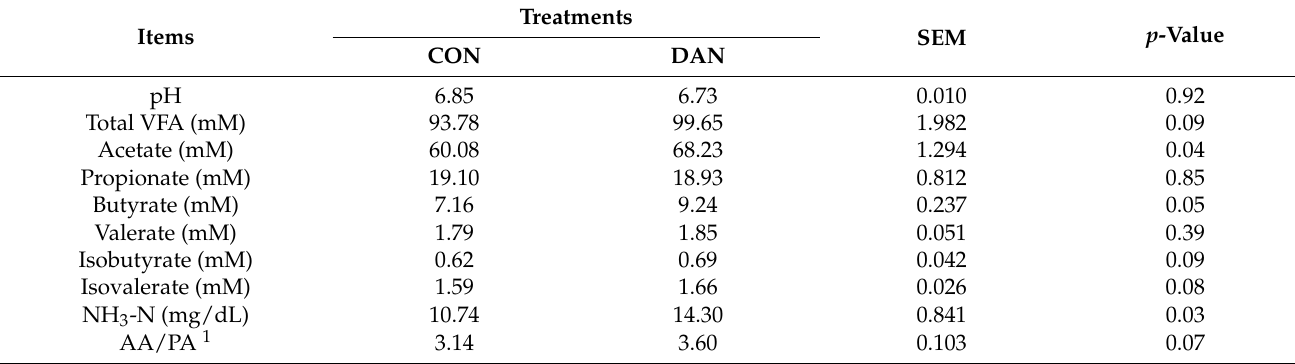
Table 3. Effects of dandelion supplementation on ruminal fermentation characteristics in mid-lactation dairy